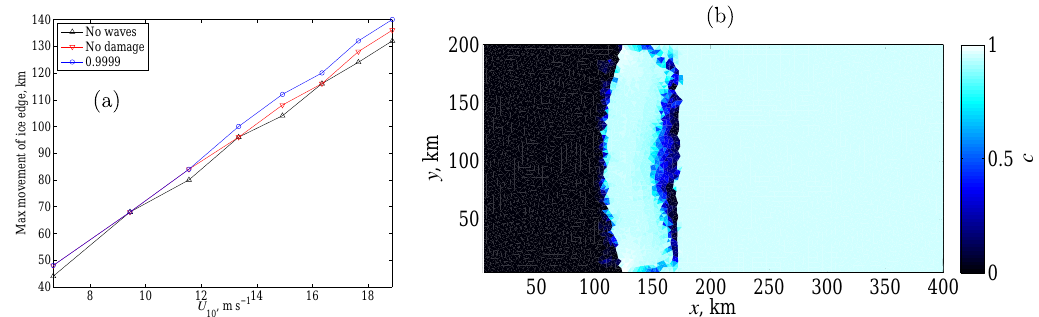
Figure 11. Panel (a) shows the maximum movement of the ice edge as a function of wind speed. The different curves show the response to wind forcing only (no waves), wind and waves without changing the EB rheology in the MIZ (no damage), and wind and waves where the damage is set to d break = 0 . 9999 in the MIZ (0.9999). (b) The effect of swell preconditioning on the response to off-ice winds.